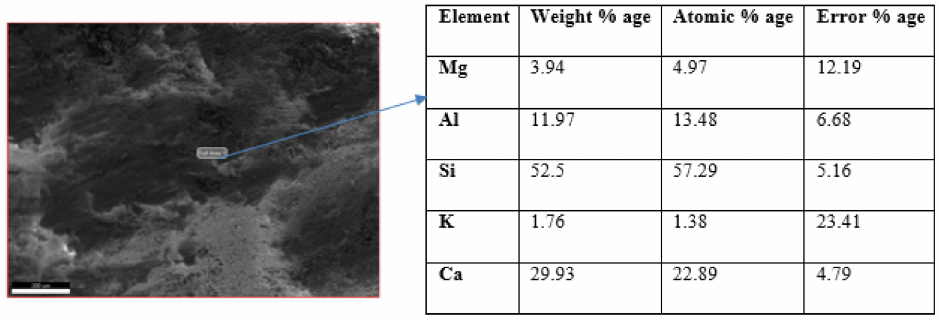
Figure 7. EDAX of concrete with its elemental